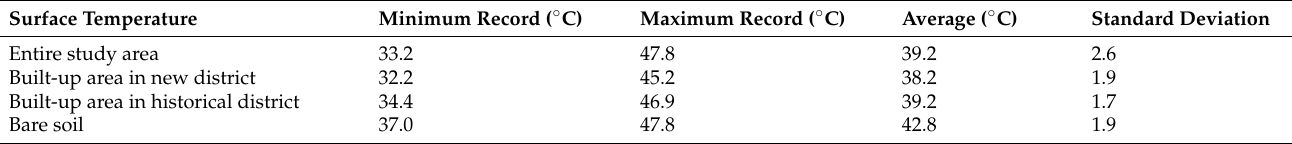
Figure 6. Surface temperature for the city of Yazd, including both the historical and the new districts. Table 3. Distribution of surface temperatures in different districts and land cover types of